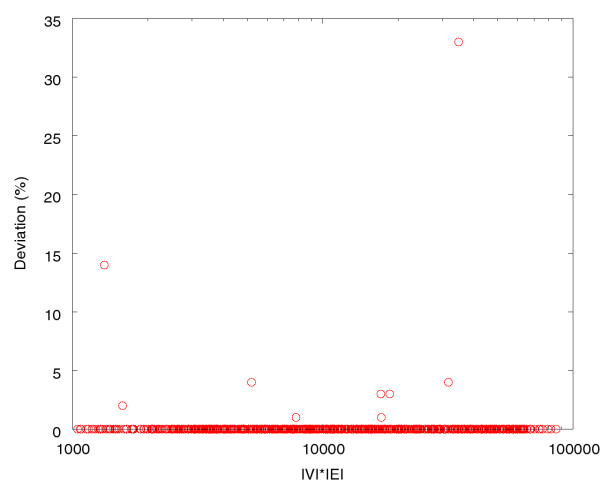
Relative cost deviations (y-axis in %) of the FORCE solutions from the optimal solutions found by the exact fixed-parameter algorithm described in [2]. The x-axis is as in Figure 2 (logarithmically scaled).